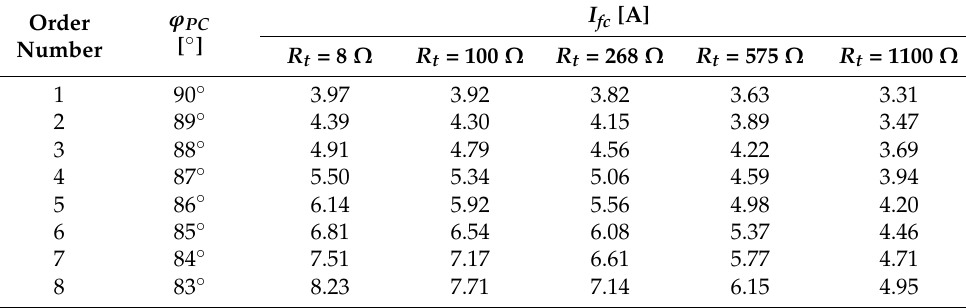
Table 8. Effective value of the fault current depending on ϕ PC , when ϕ c = 88 ◦ . Order